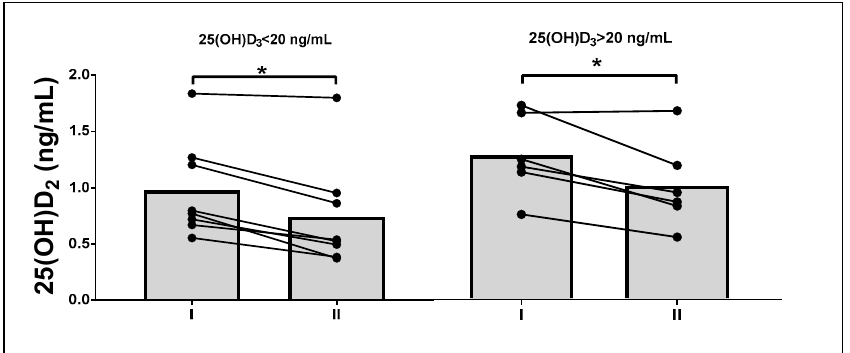
Figure 3. Effects of 8 d of fasting on serum levels of 25(OH)D 2 in subgroups with different baseline 25(OH)D 3 levels (by repeated-measures analyses of variance with post-hoc tests, * p < 0.05). No differences in changes in the IL-10 levels were apparent between the analyzed subgroups ( p = 0.21, η 2 = 0.15).